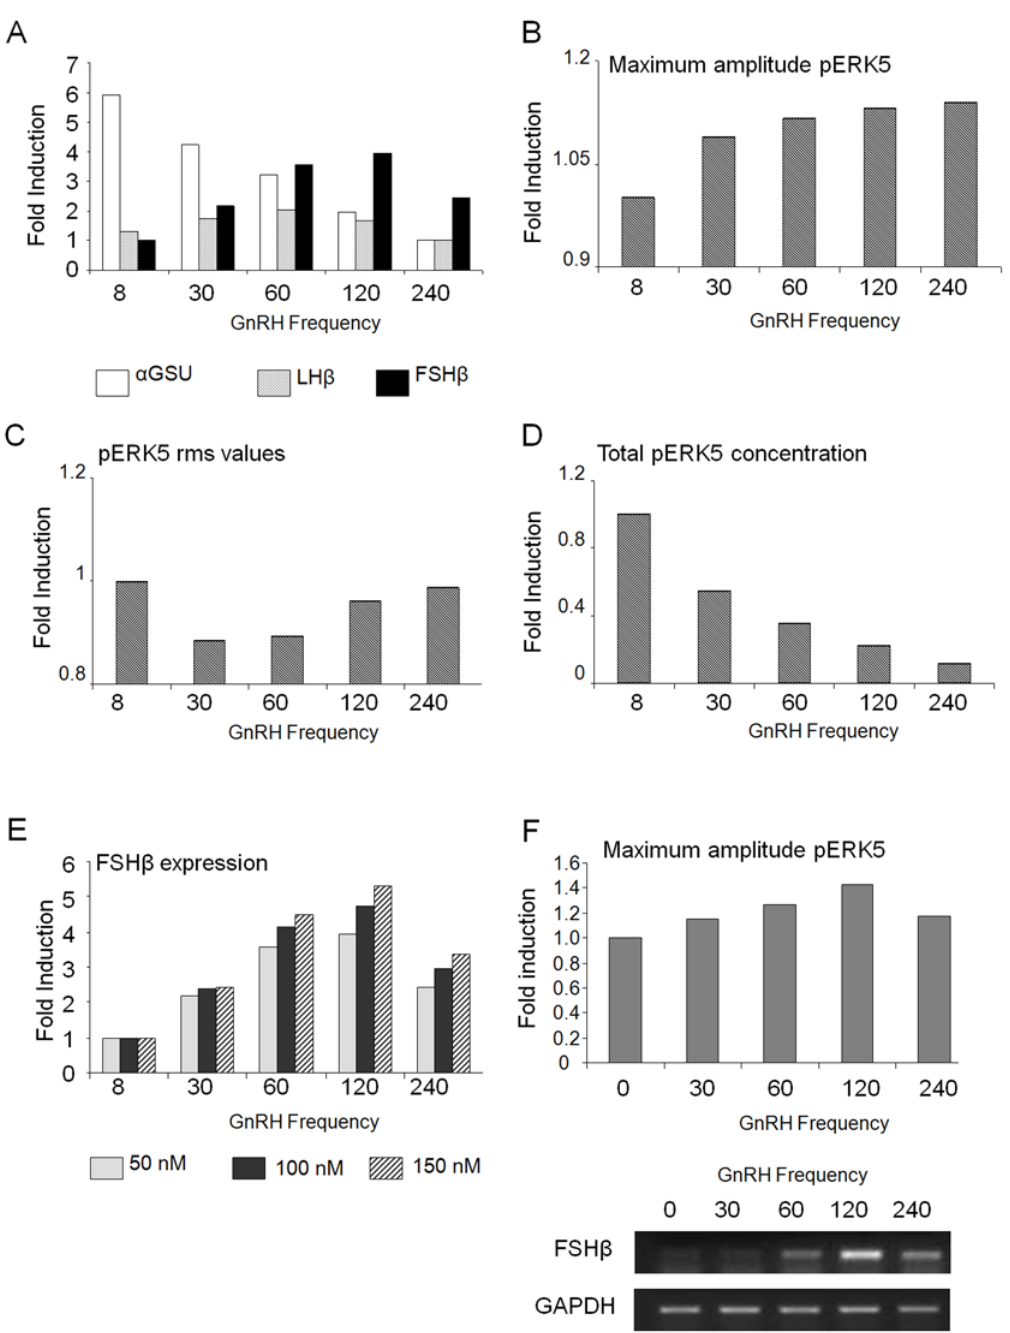
Figure 4. Expanded model with phosphatase feedback demonstrates differential gene expression, which is enhanced by ERK5. (A) The default expanded model with phosphatase feedback was simulated for 1440 min for the same five frequencies and expression trends for each subunit were plotted as described in Figure 1. Thereafter, (B) the maximum steady-state amplitude, (C) the rms value, and (D) the total concentration of activated ERK5 were computed and plotted. (E) The expanded model was then re-simulated with various concentrations of total ERK5 (50, 100 or 150 nM), and the expression trends of FSH b were plotted. (F) To validate these models, maximum amplitude pERK5 was measured in cells after administering 5 min GnRH pulses at the marked frequencies for 4 h. Protein was collected at 0–90 min after the last pulse and analyzed, together with an internal standard for comparisons, by western blotting for pERK5 and total ERK5. The maximum amplitude for each pulse-frequency is shown after normalization to total ERK levels and to the internal standard. Also shown in the bottom panel are the FSH b mRNA levels after the last